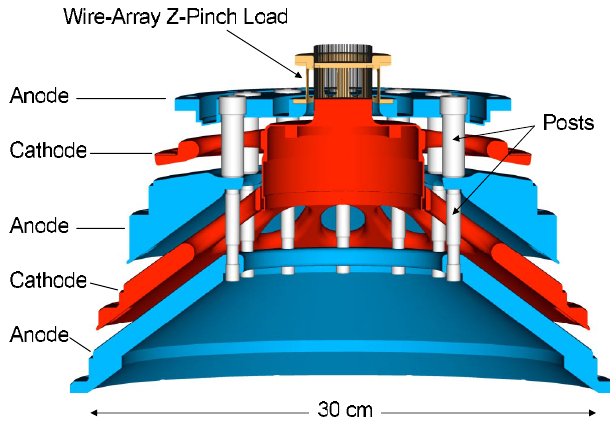
FIG. 1. (Color) Cutaway drawing of the Z machine DPH con- volute including a wire-array z -pinch load. Anode hardware is shown as blue and grey parts and cathode parts are shown in red.